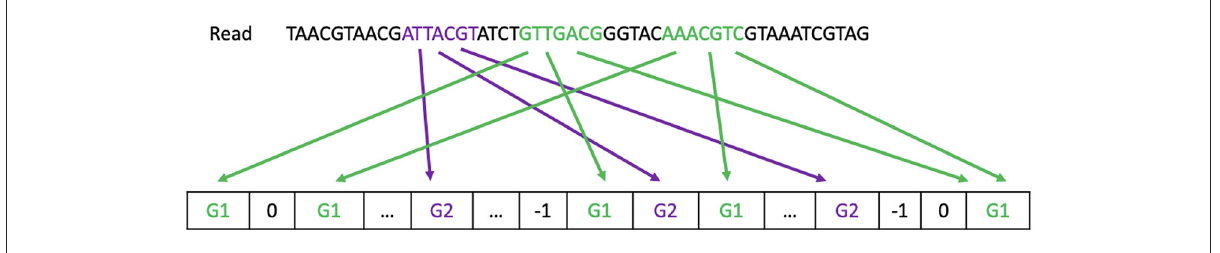
FIGURE1 Read processing. The majority strategy predicts the read comes from G1. The First-hit strategy predicts the read comes from G2. The One-or-nothing strategy discards the